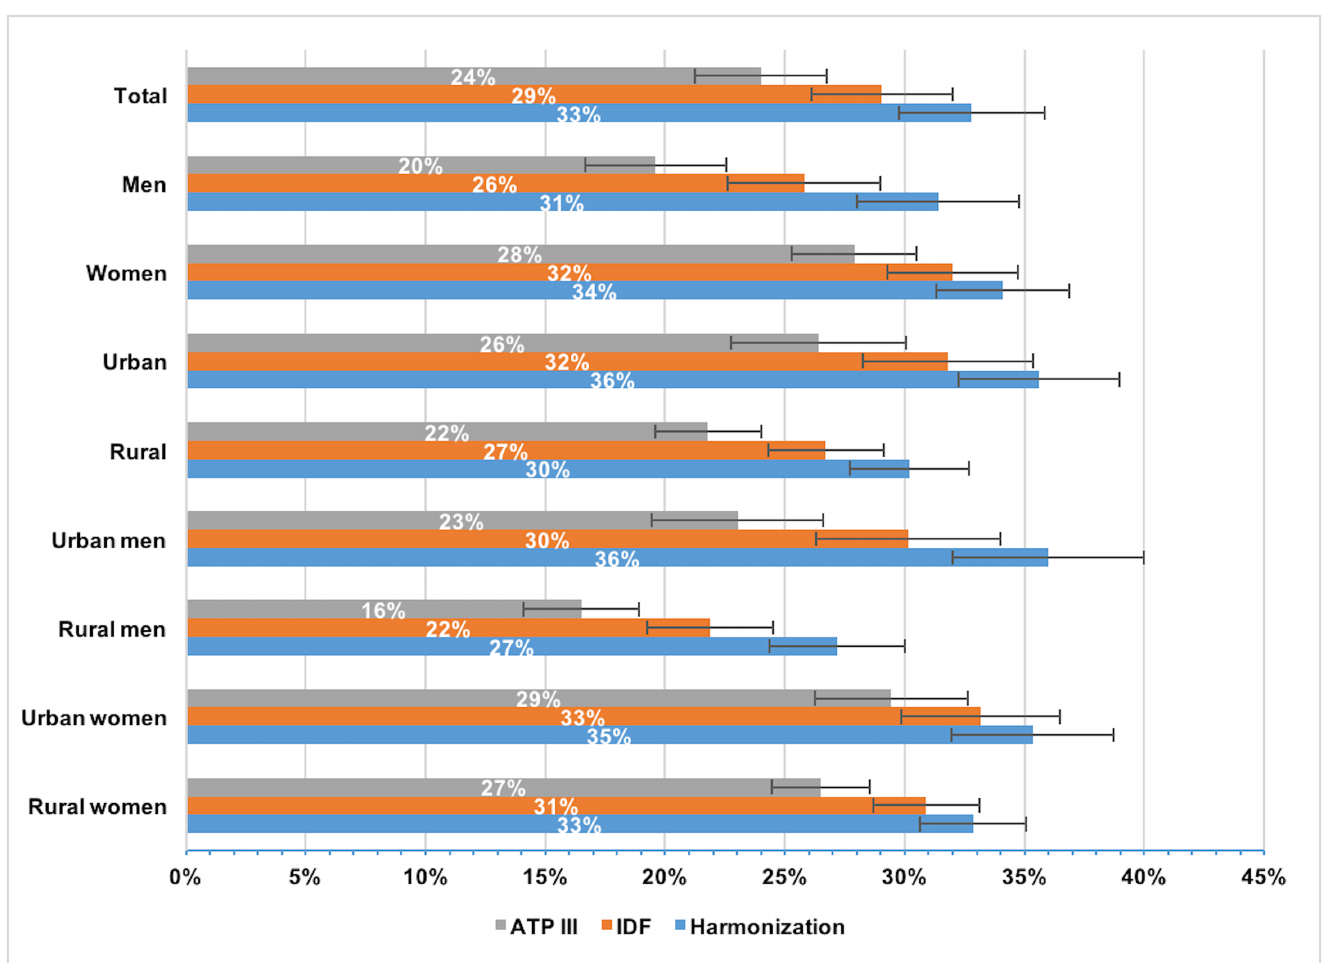
Fig 1. Age standardized prevalence of ATP III, IDF and Harmonization metabolic syndrome. Adjustment has been performed for sex and urban-rural location.